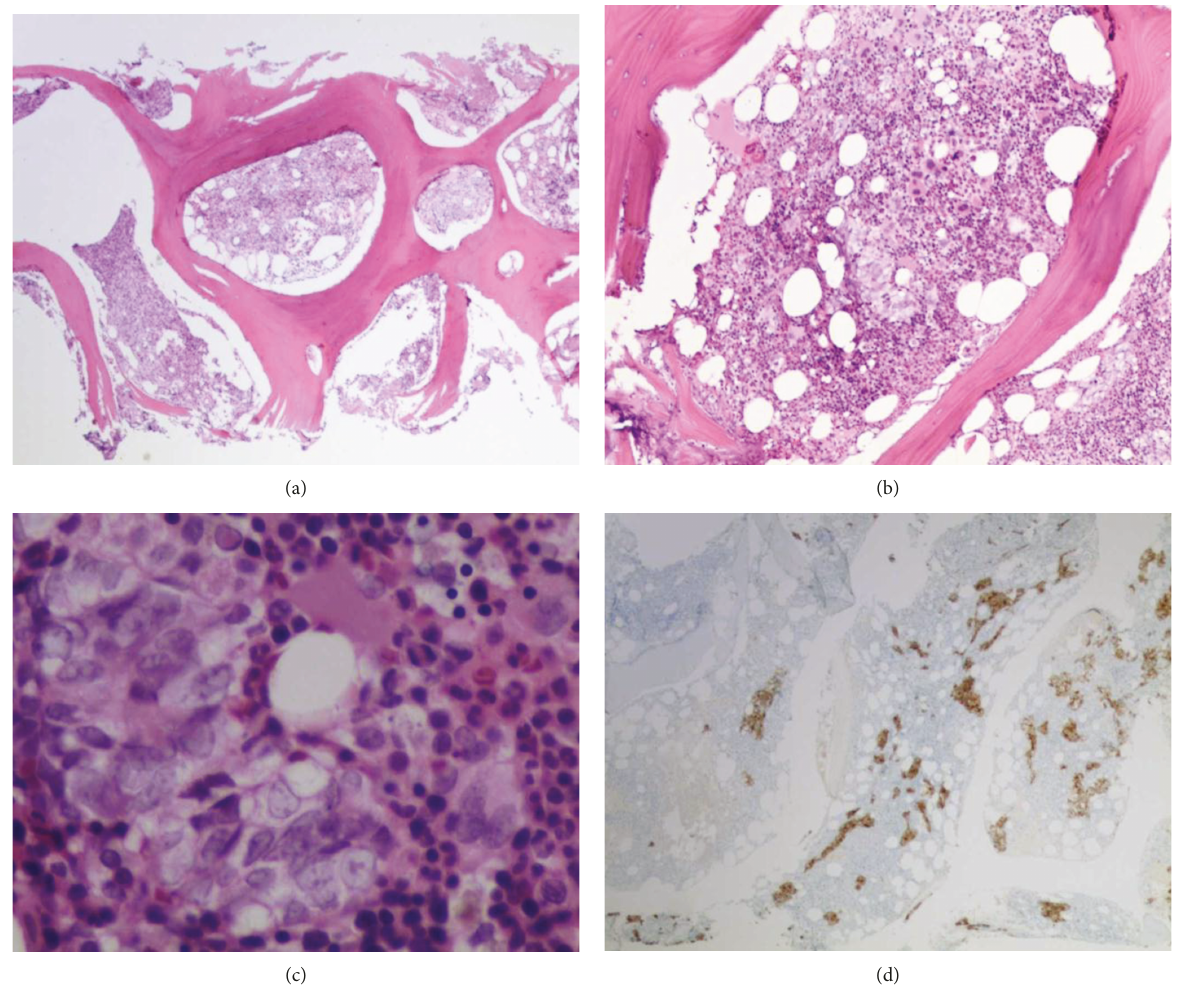
Figure 1: (a) Low-power bone marrow (H&E, × 40) showing clusters of epithelioid cells on small aggregates within hypercellular bone marrow. (b) High-power bone marrow (H&E, × 200) showing clusters of epithelioid cells on small aggregates within hypercellular bone marrow. (c) High-power bone marrow (H&E, × 600) showing clusters of epithelioid cells on small aggregates within hypercellular bone marrow. (d) Low-power bone marrow with OSCAR stain highlighting